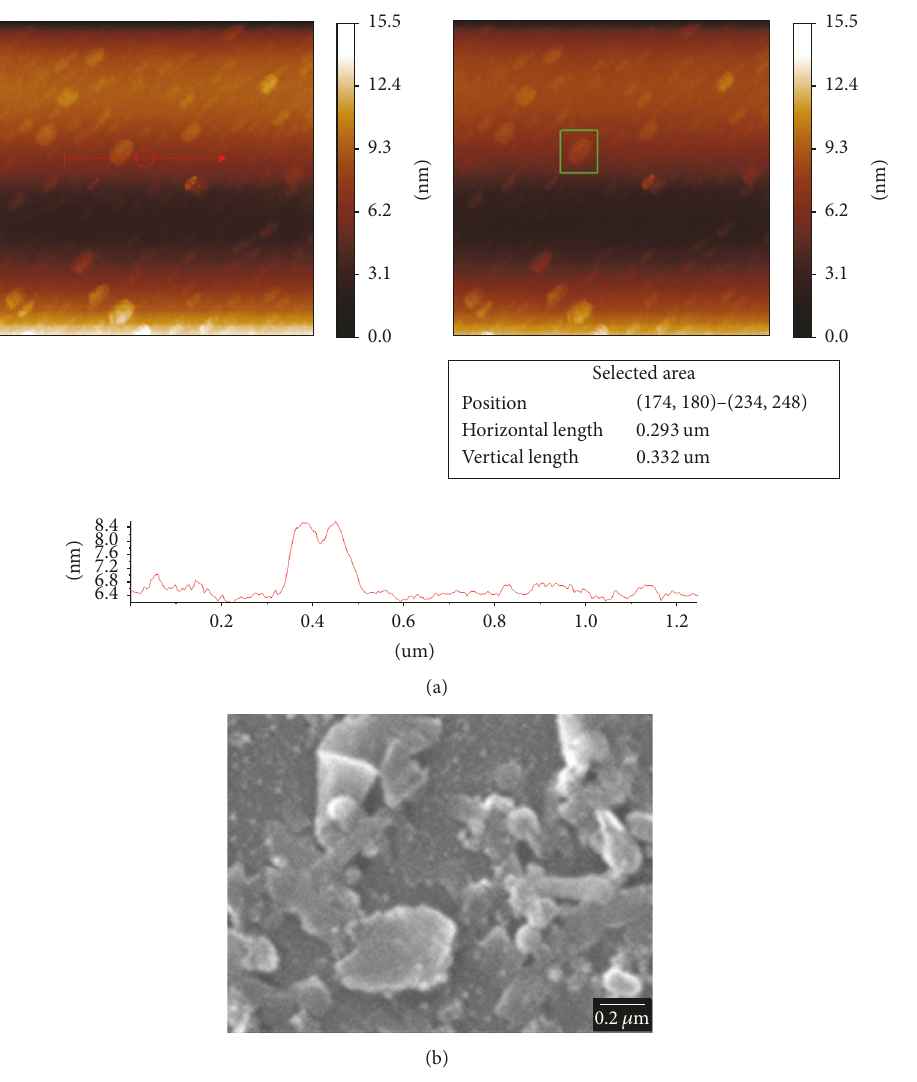
Figure 1: (a) Representative AFM image and dimensional analysis for MoS 2 nanosheets length ( 𝐿 ) and number of layers ( 𝑁 ). (b) Scanning electron micrograph of exfoliated MoS 2 for lateral dimension